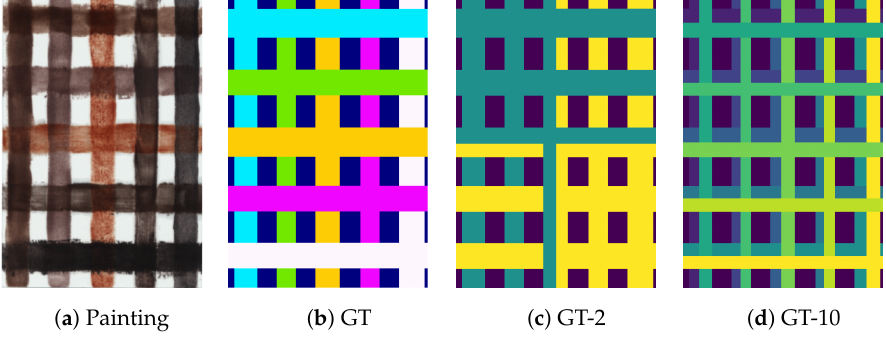
Figure 3. Scheme of creating artificial classes on Pigment dataset. From left: false-colour RGB (bands 50, 27, 17) image of the painting ( a ), original class labels ( b ), classes artificially joined into 2 sets ( c ), and classes artificially split into 10 sets ( d ). Dark rectangles denote background, excluded from the